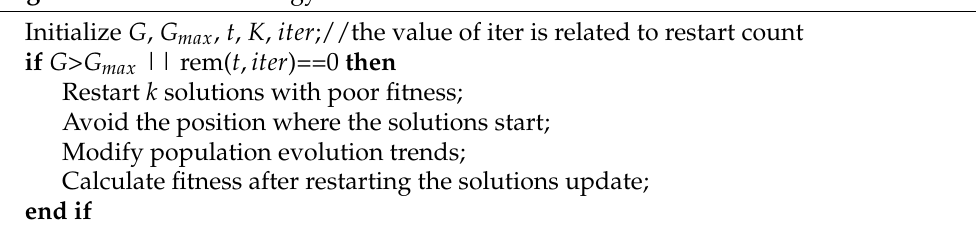
Algorithm 2 Restart Strategy